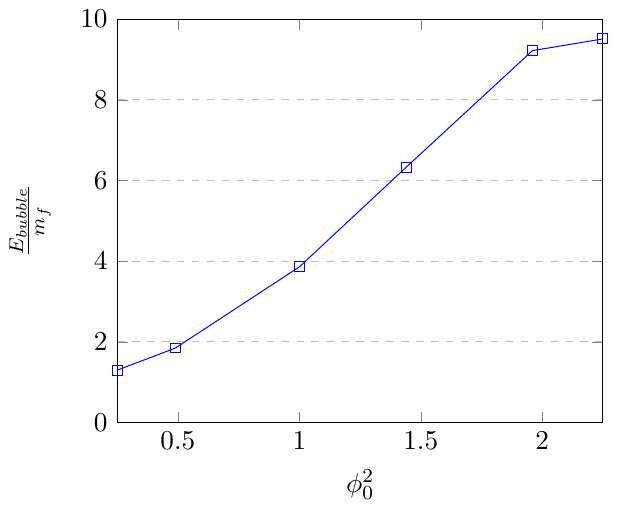
Figure 11 . The critical bubble energy in 1+1 dimensions for different values of φ 0